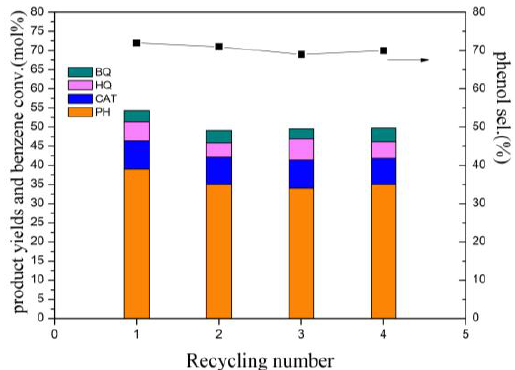
Figure 2. The stability of catalyst. Reaction conditions: m TS-1 /m benzene = 0.34, 40.0 mL H 2 O, 5.6 mmol C 6 H 6 , reaction time 45 min, 0.80 mL H 2 O 2 (30%), reaction temperature 70 ◦ C.